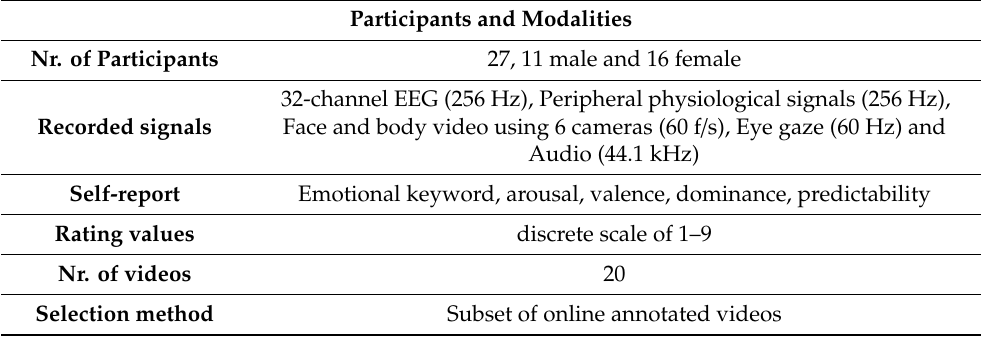
Table 3. Summary of DEAP